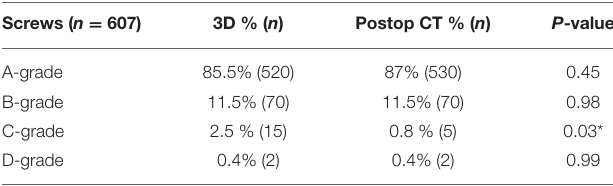
TABLE 2 | Graduation and comparisons using chi-squared test